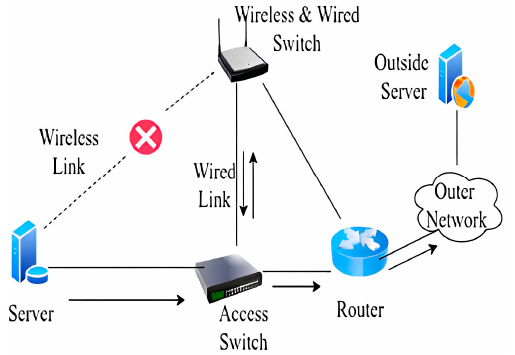
Figure 7. Scenario C [11].